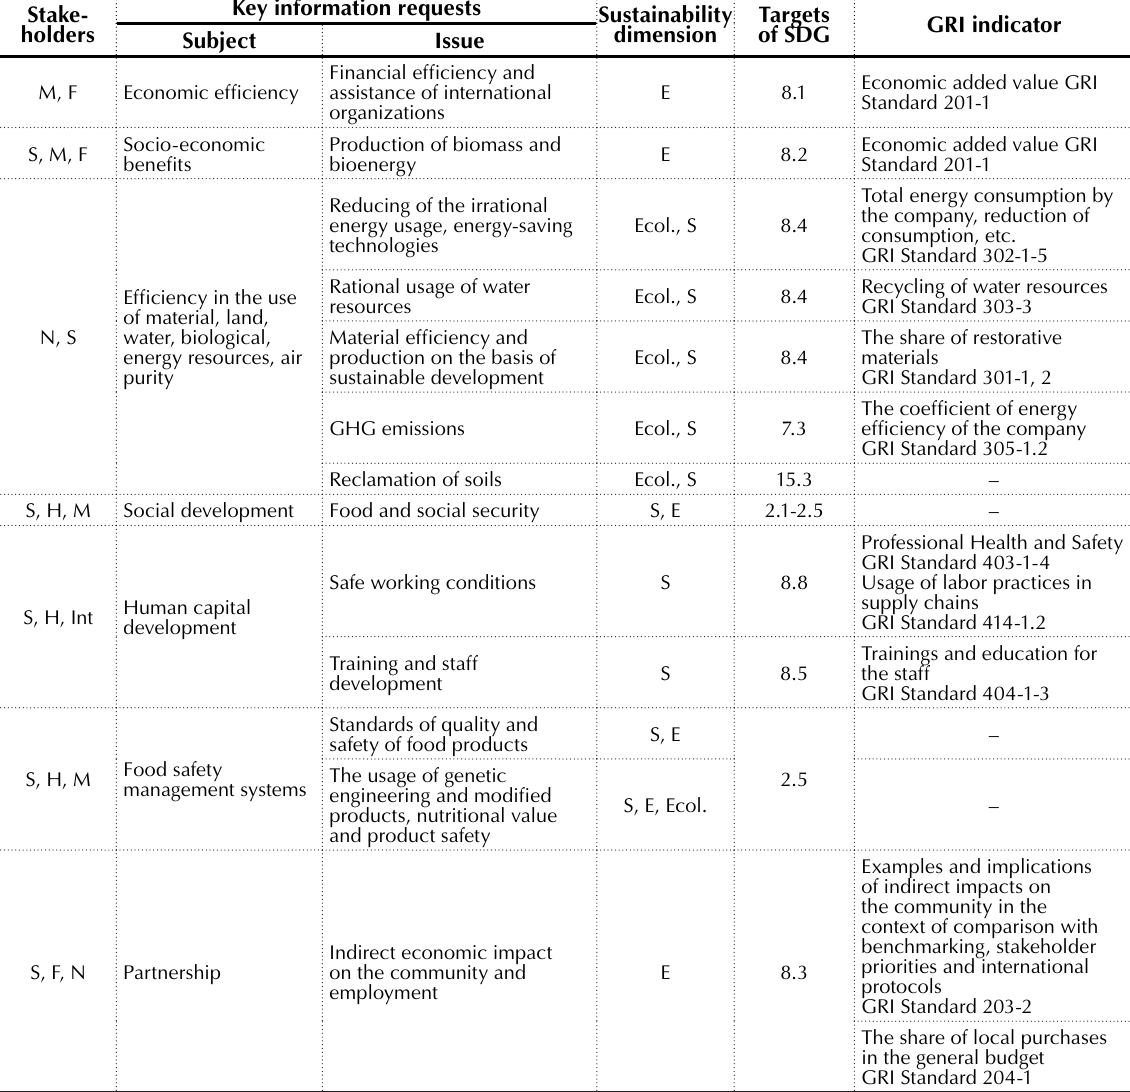
Table 2. Classification of stakeholders’ information requests relevant to SDG, their targets and indicators economy (based on the example of food production